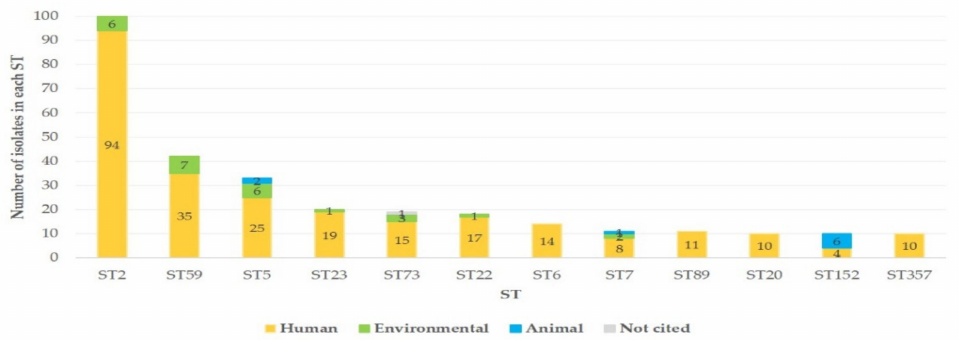
Figure 1. Histogram of the number of Staphylococcus epidermidis isolates in STs with ≥ 10 isolates within each ST, in the MLST database, according to the number of isolates distributed into each one and the source of the isolates (depicted in the colour of the bars). MLST: multi-locus sequence typing; ST: sequence